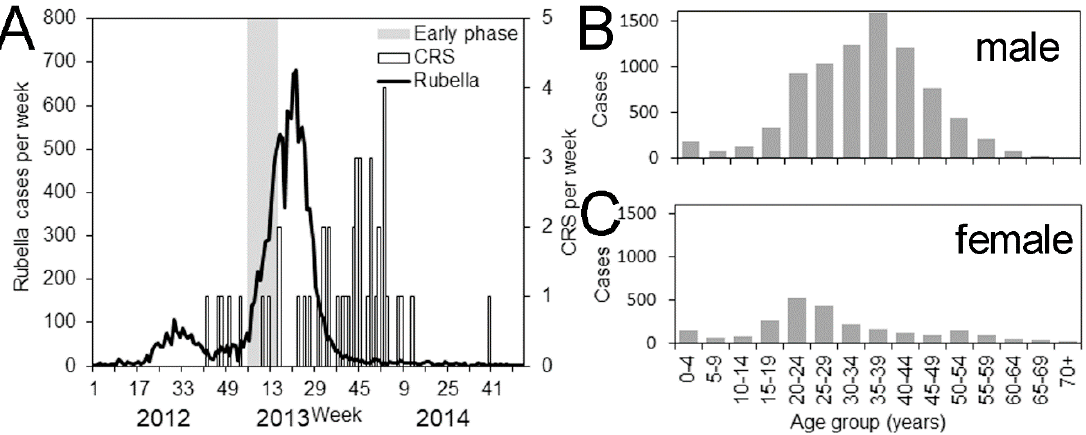
Figure1. Epidemiologicalcharacteristicsoftherubellaepidemicfrom2012–2013inJapan. ( A )Epidemiccurve Figure 1. Epidemiological characteristics of the rubella epidemic from 2012–2013 in Japan. ( A ) ofrubellacases(boldline)andnotificationofcongenitalrubellasyndrome(bars). Epidemiccurveistheweekly Epidemic curve of rubella cases (bold line) and notification of congenital rubella syndrome (bars). surveillance dataset of rubella that rests on notifications adhering to the Infectious Disease Law of Japan. Epidemic curve is the weekly surveillance dataset of rubella that rests on notifications adhering to the The gray shaded area represents approximately a linear growth period in 2013 from which we quantified Infectious Disease Law of Japan. The gray shaded area represents approximately a linear growth the age- and sex-dependent next generation matrix. ( B , C ) Age distribution of notified rubella cases for males period in 2013 from which we quantified the age- and sex-dependent next generation matrix. ( B , C ) and females, Age distribution of notified rubella cases for males and females, respectively.